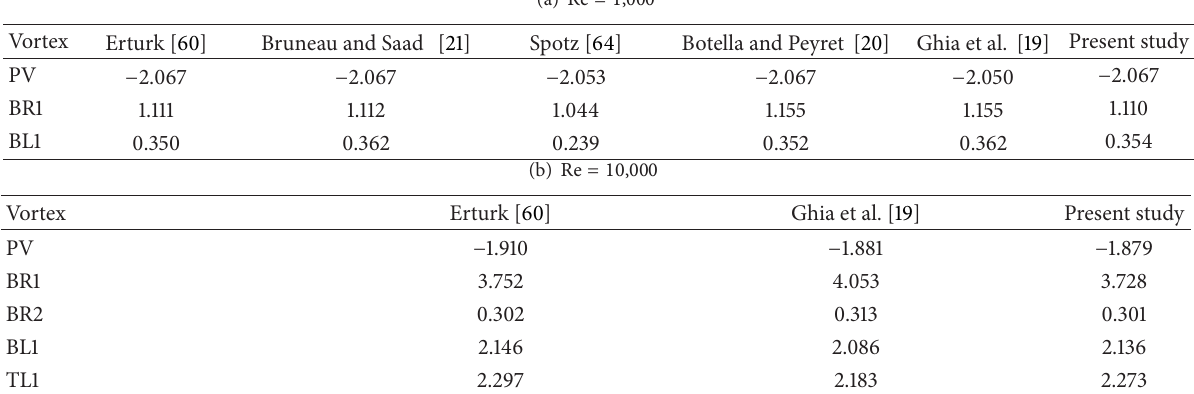
Figure 9: Streamline configuration of side cavity problem by Re. Table 4: Comparison of vorticity intensities for square side-cavity